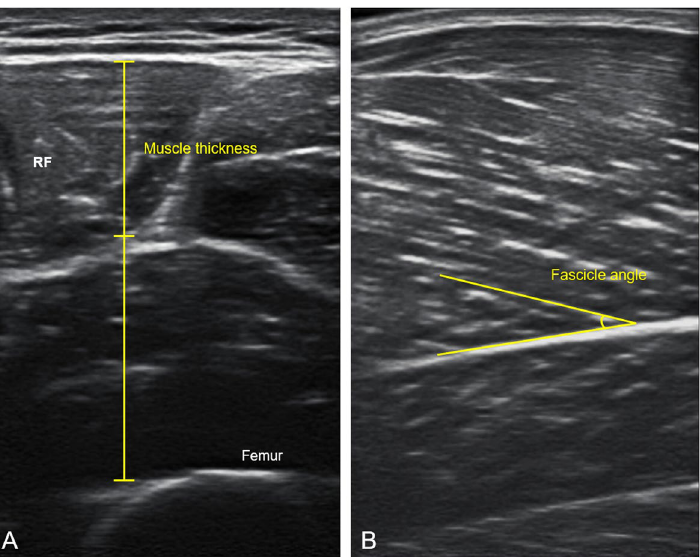
Figure 1. Representation of muscle architecture measurement of rectus femoris (RF) at the sonographic image (A) muscle thickness; (B) fascicle angle.